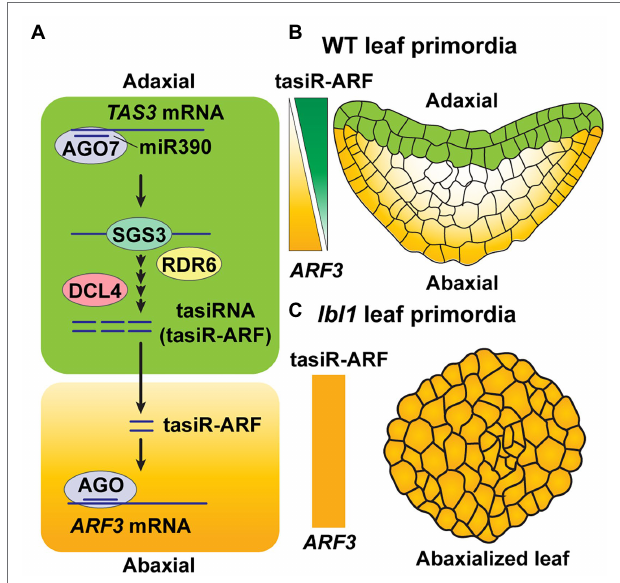
FIGURE 3 | Mobile tasiRNA-mediated leaf patterning. (A) Mature miR390 accumulates broadly throughout the leaf in Arabidopsis . AGO7, which is specifically expressed on the leaf adaxial side, loads miR390 and then targets TAS3 transcripts. Production of 21-nt tasiRNAs then occurs through the activities of SGS3, RDR6, and DCL4 (see Figure 1B ) in adaxial side of the leaf. The 21-nt tasiRNAs, referred to as tasiR-ARF3, move toward the abaxial area to target ARF3 transcripts, in trans , to repress its expression (Montgomery et al., 2008; Chitwood et al., 2009). (B) In Arabidopsis wild-type (WT) leaf primordia, tasiR-ARF3 traffics intercellularly, from the top two layers on the adaxial side, where they are synthesized, to form a concentration gradient of tasiR-ARF3 across the leaf; this generates an opposing gradient of ARF3 accumulation, which establishes leaf polarity (Montgomery et al., 2008; Chitwood et al., 2009). (C) LEAFBLADELESS1 (LBL1) is the ortholog of SGS3 in maize. A mutant form of LBL1 , lbl1 , disrupts tasiRNA biogenesis on the adaxial layers of leaf primordia, thereby giving rise to an abxialized leaf phenotype in maize (Singh et al.,